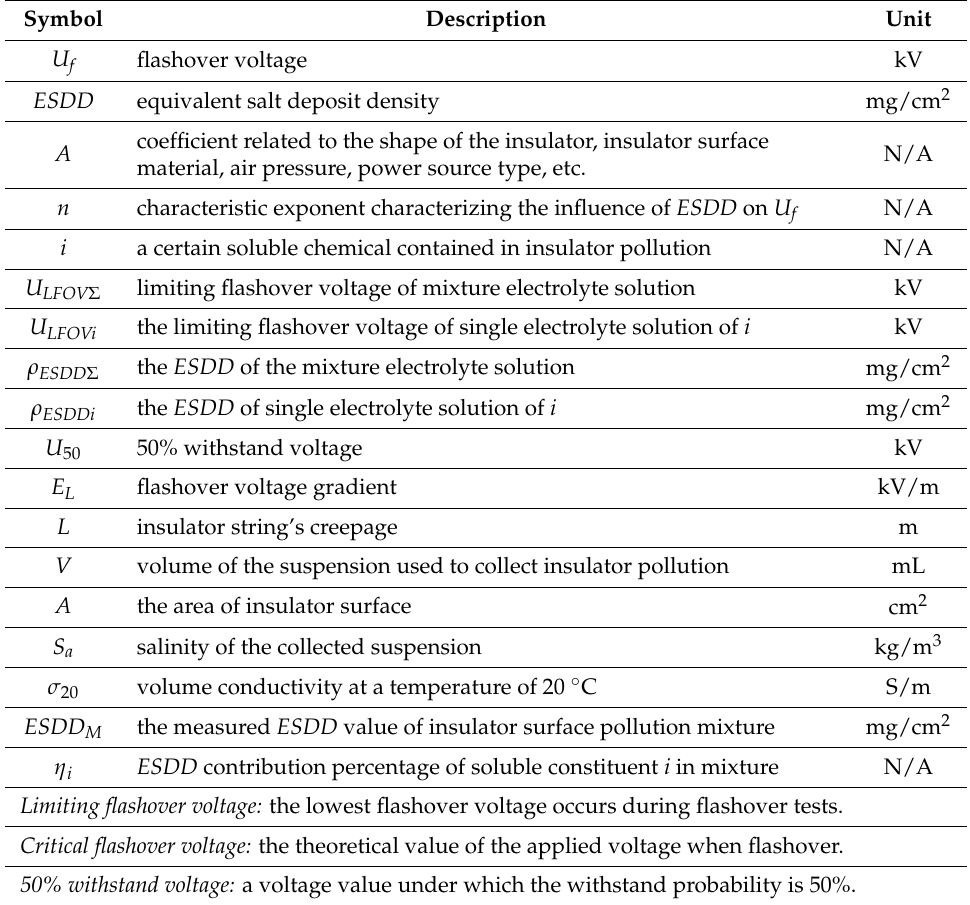
Table 1. List of principal symbols and